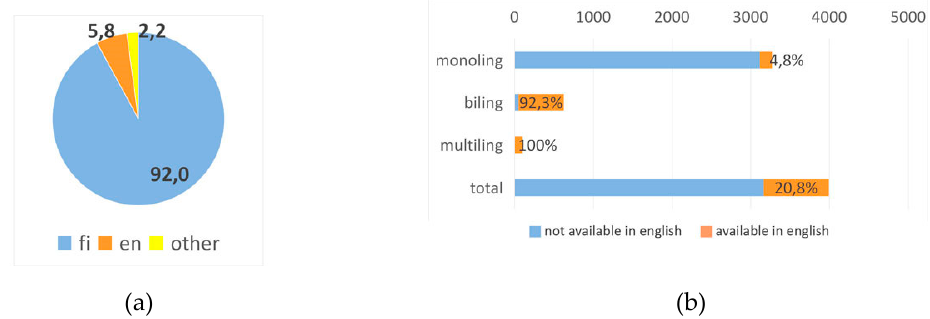
Figure A9. Visualization of the results for domain fi. ( a ) Primary languages pie chart and ( b ) English